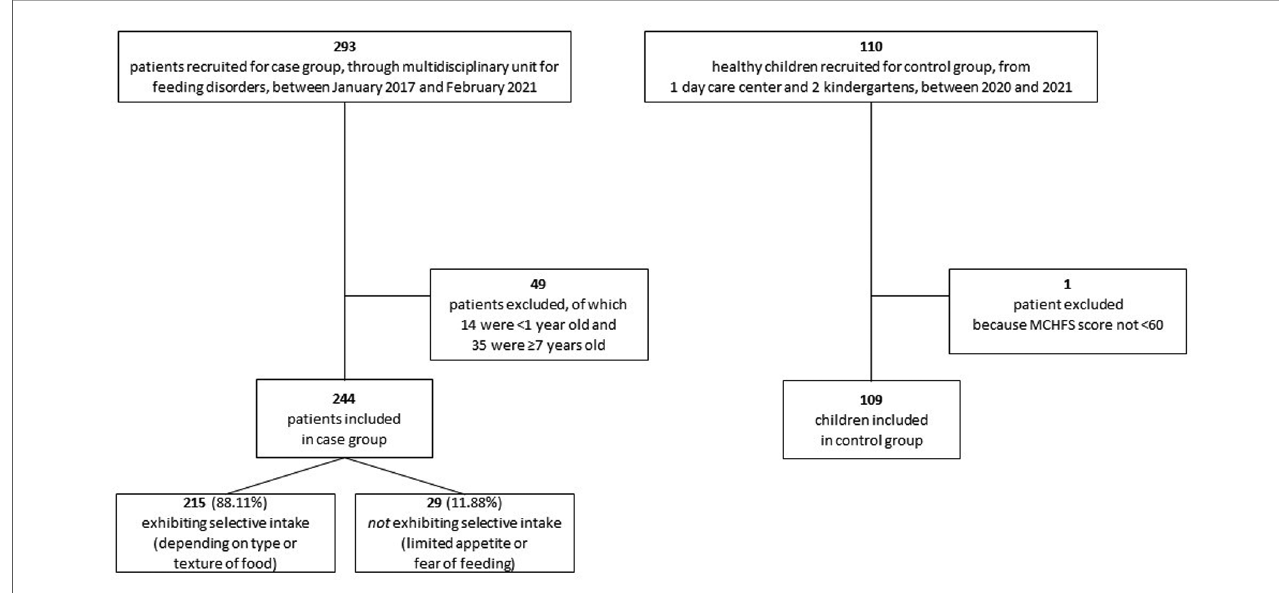
FIGURE 1 Study recruitment fl owchart. MCHFS, Montreal Children ’ s hospital feeding scale.